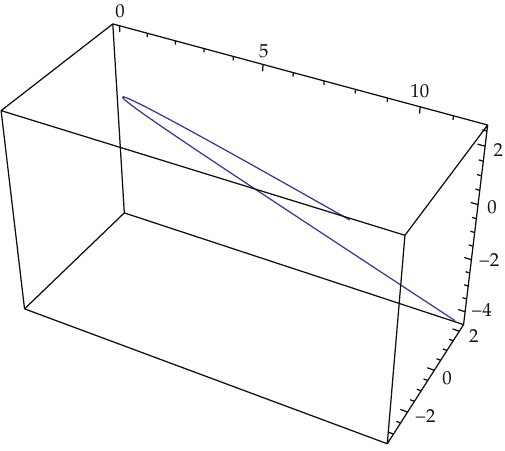
Figure 4: The Lie-Trotter integrator of the system (cid:7) 3.8 (cid:8) (cid:7) c 1 (cid:6) 1, c 2 (cid:6) 2, c 3 (cid:6) 3, k (cid:6) 10, and x 1 (cid:7) 0 (cid:8) (cid:6) x 2 (cid:7) 0 (cid:8) (cid:6) x 3 (cid:7) 0 (cid:8) (cid:6) 1 (cid:8)